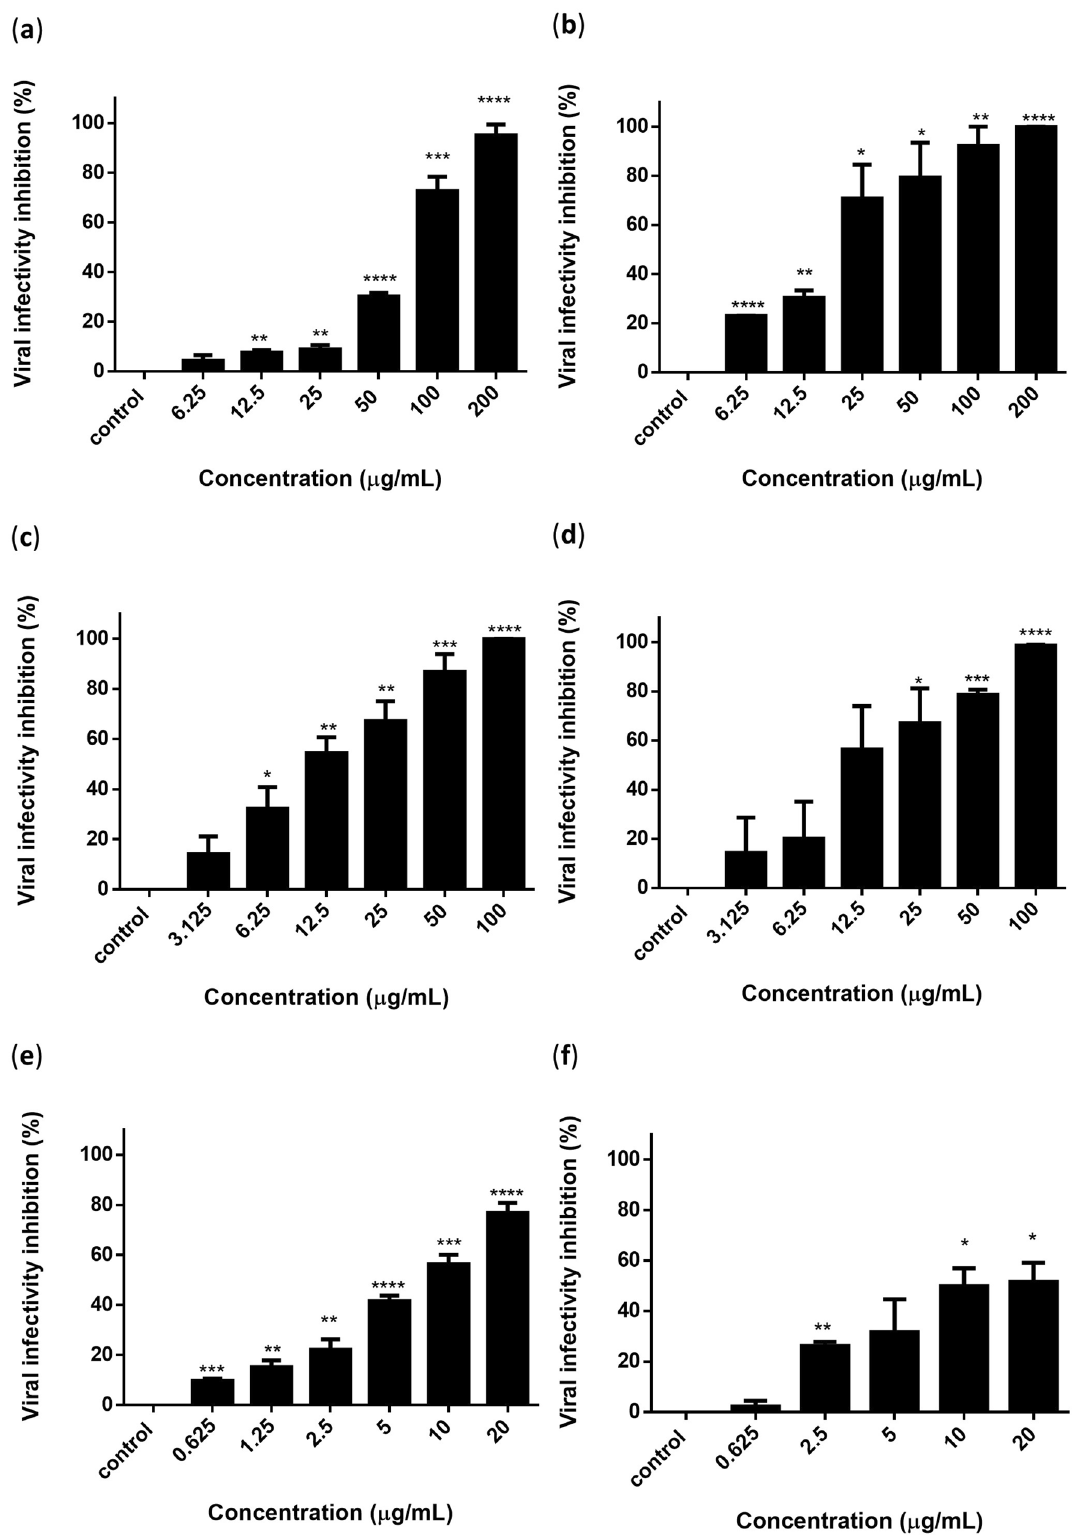
Figure 2. Silymarin, baicalein, and baicalin exhibited virucidal activity against extracellular DENV-3 in a dose-dependent manner. The inhibition of viral infectivity by silymarin was determined by ( a ) FFURA and ( b ) quantification of RNA copy number. Inhibition of viral infectivity by baicalein was determined by ( c ) FFURA and ( d ) quantification of RNA copy number. Inhibition of viral infectivity by baicalin was determined by ( e ) FFURA and ( f ) quantification of RNA copy number. Data presented as mean ± SEM. Error bars indicate the range of values obtained from three independent experiments. *P < 0.05, ** P < 0.01, ***P < 0.001, ****P < 0.0001 indicates a significant difference compared to the negative control analyzed by the t